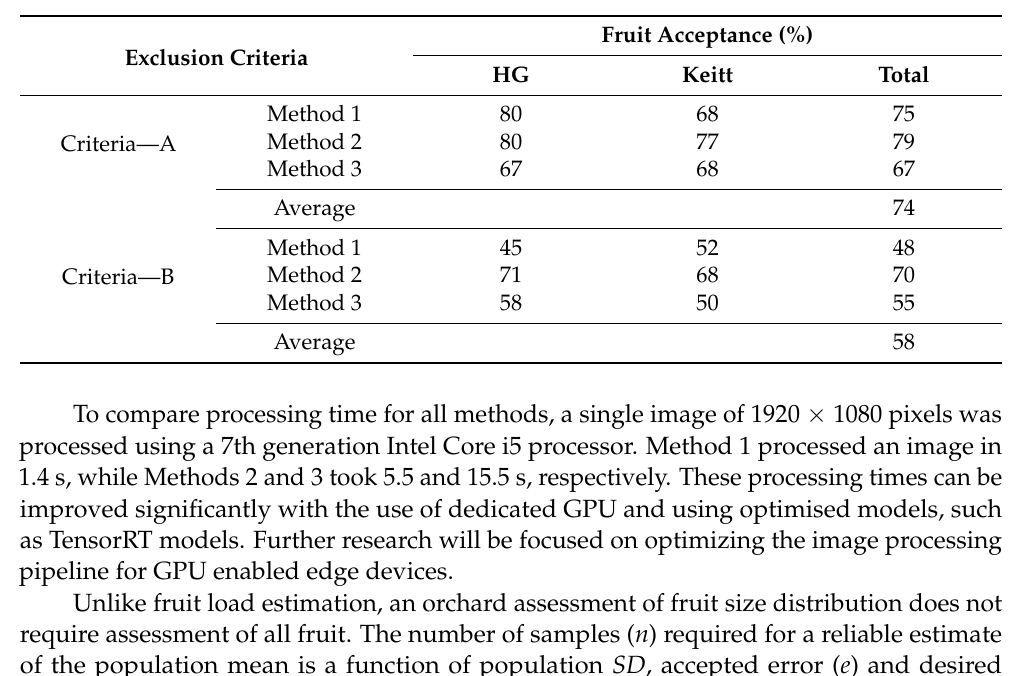
Table 6. Percentage of sample fruit accepted by two criteria for each of three sizing methods.